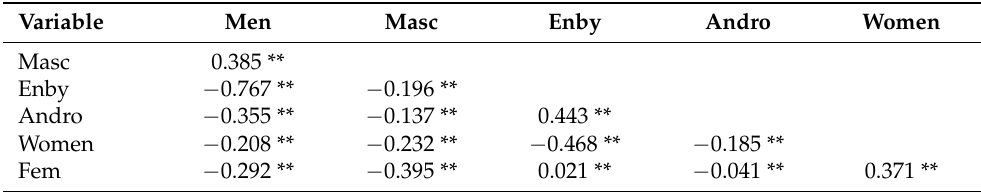
Table 6. Correlating gender identity and gender expression. Variable